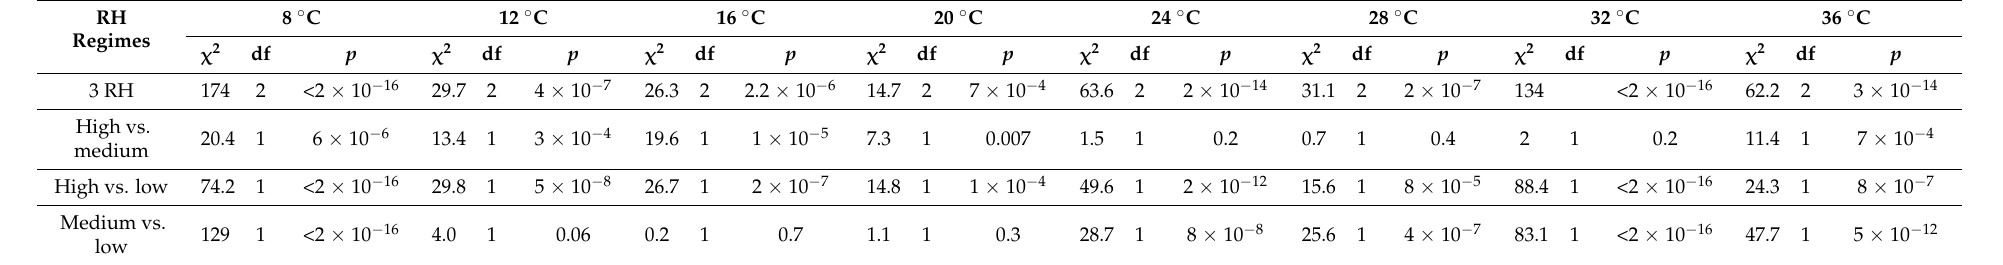
Table 1. Log-Rank test comparing age-specific survival rate ( lx ) curves of Hypera postica eggs at three RH regimes (high: 90% < RH < 100%; medium: 50% < RH < 75%; and low: 10% < RH < 35%) at eight temperatures (from 8 to 36 ◦